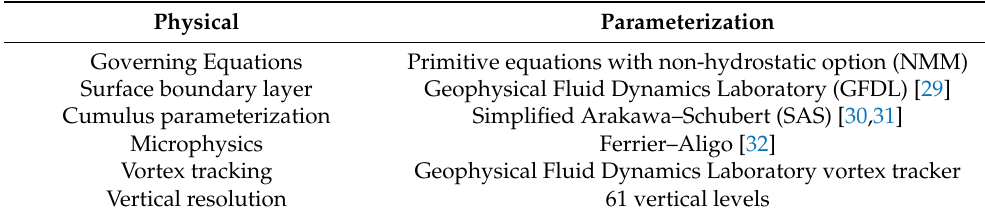
Table 2. Parameterizations used in the implementation of HWRF version